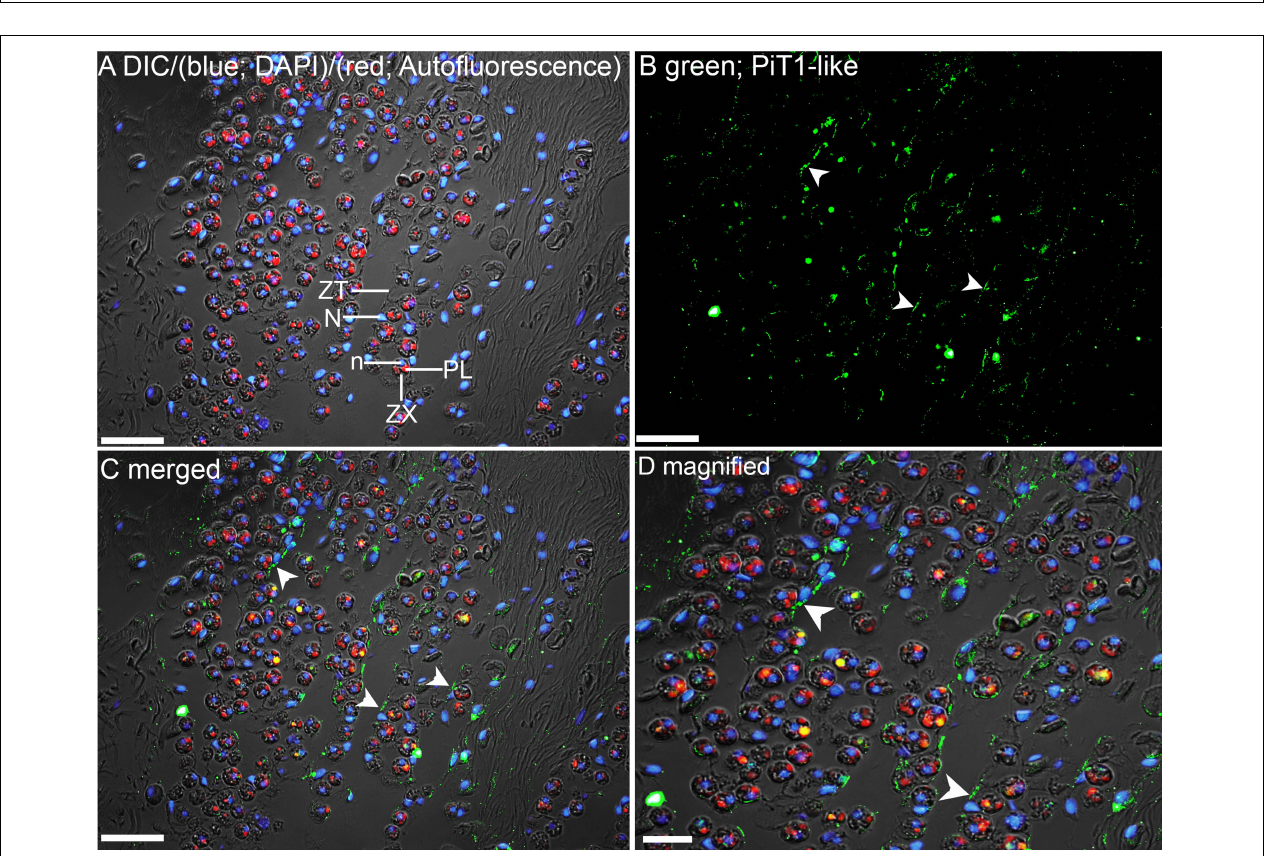
FIGURE 6 | Immunofluorescence localization of a homolog of sodium-dependent phosphate transporter protein 1 (PiT1-like) in the outer mantle of Tridacna squamosa exposed to 12 h of light. (A) Overlaid image of differential interference contrast (DIC), auto-fluorescence of symbiotic dinoflagellates (zooxanthellae, ZX) in red, merged with that of DAPI (blue) staining of zooxanthellal nucleus (n) and nucleus (N) of host tubular epithelium (ZT). Red auto-fluorescence of ZX was due to plastid (PL). (B) Green immunofluorescence staining of the epithelial cell linings of the basolateral membrane of ZT (labeled with arrowheads) indicates presence of PiT1-like protein. (C) Merged images of DIC, DAPI, red, and PiT1-like immunolabeling. (D) Magnified view of (C) . Scale bar: 20 µ m.